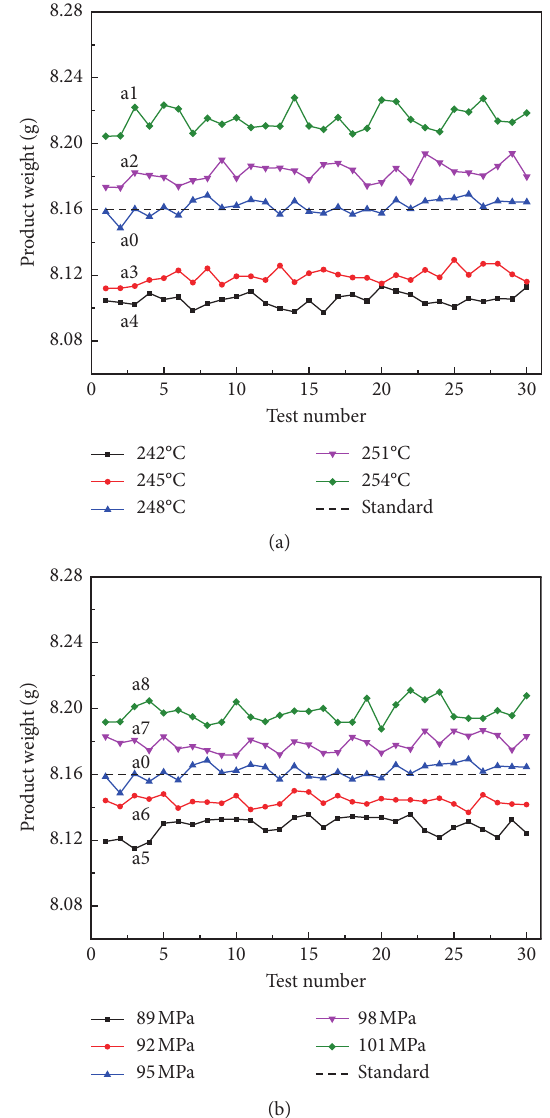
Figure 7: Verification results: product weight under (a) varying injection temperature; (b) varying packing